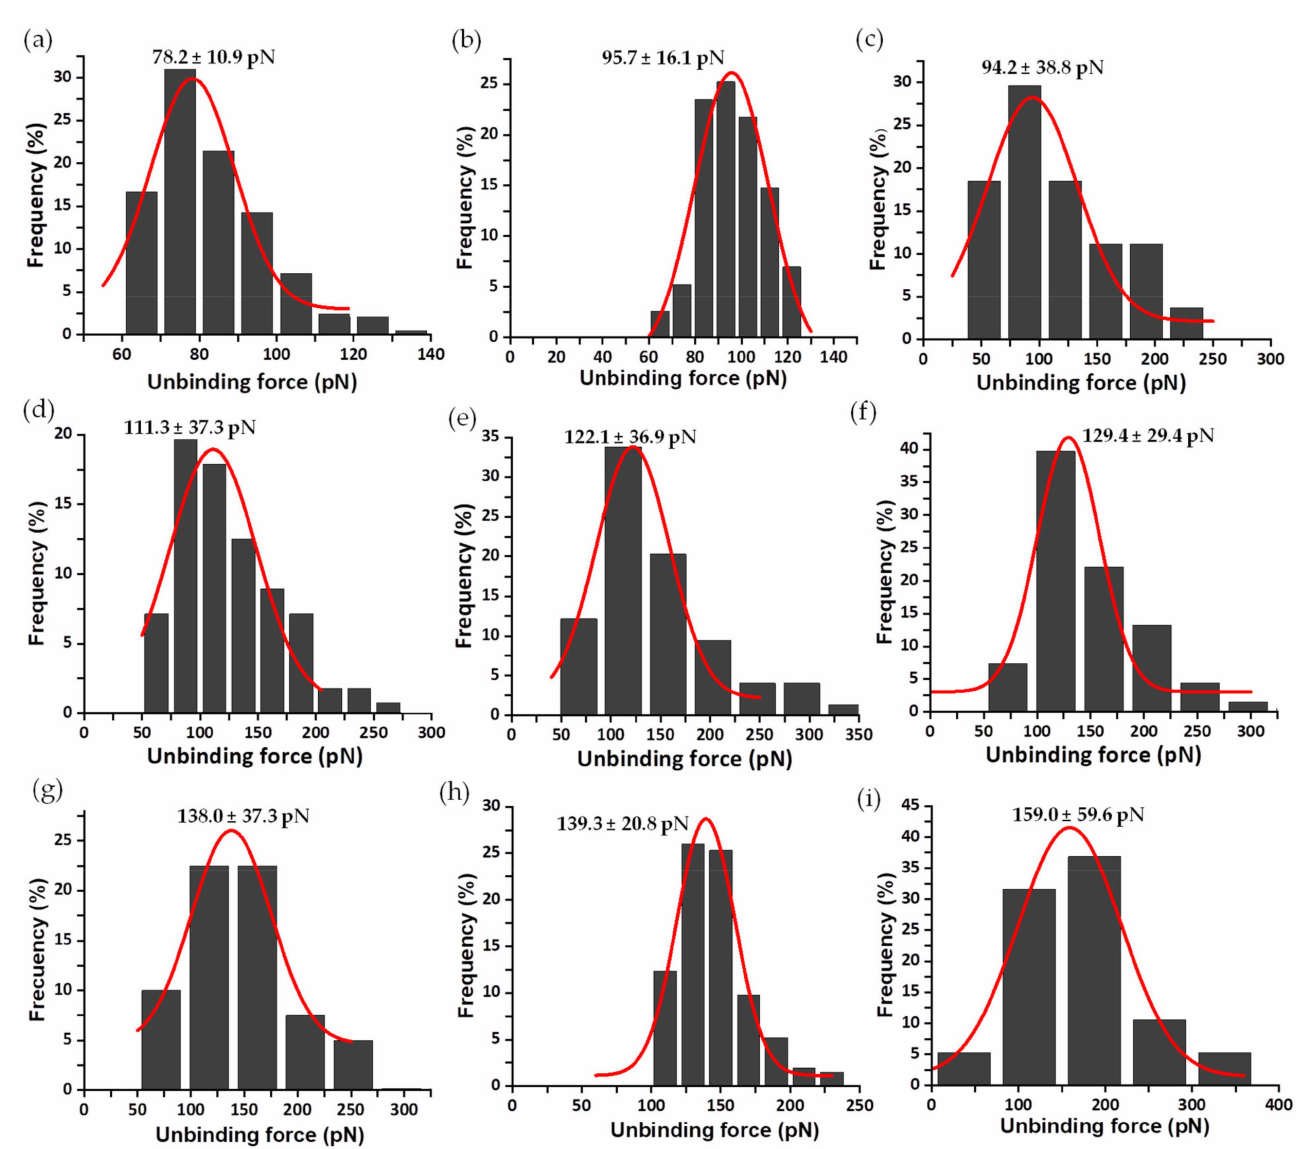
Figure 7. Force histogram distributions for Y303S AnFNR ox :NADP + complexes. Data force obtained operating at R values of 3 ( a ), 20 ( b ), 31 ( c ), 43 ( d ), 50 ( e ), 61 ( f ), 69 ( g ), 79 ( h ), and 88 ( i ) nN/s. The width of the bars varies in each case, depending on the optimum fit with the Gaussian function shown in red. Data from R 10 nN/s were also measured, but are shown below. The fitting provides the most probable unbinding forces corresponding to the rupture of a single complex and is shown on the corresponding